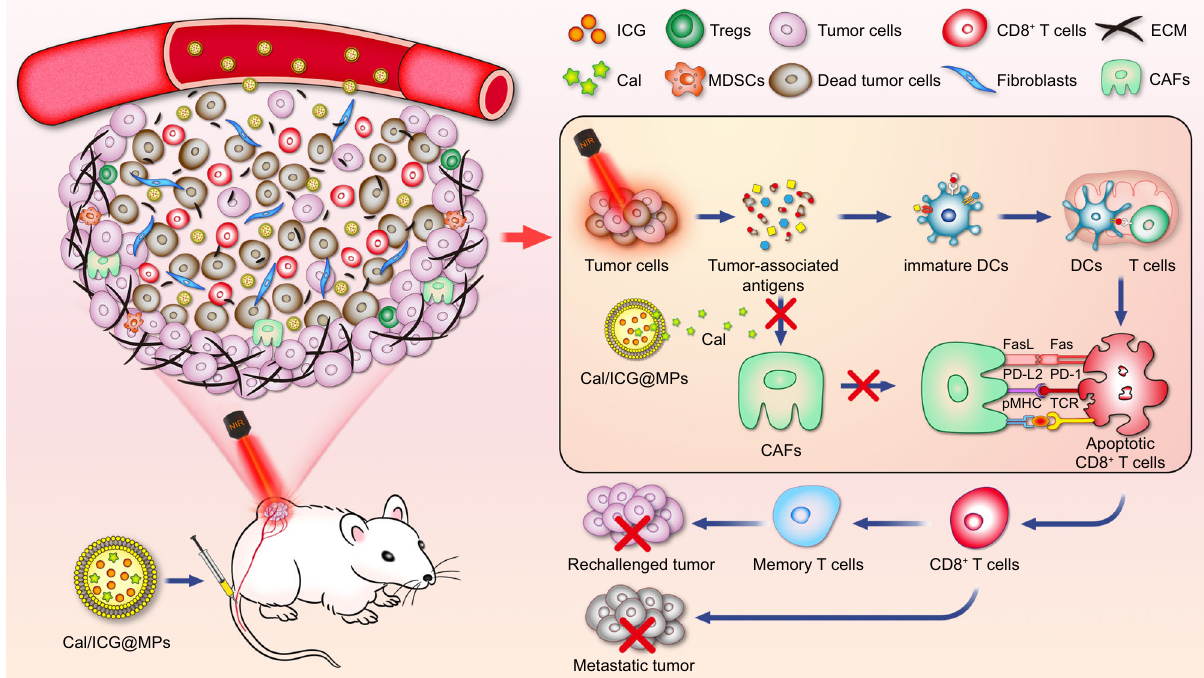
Fig. 1 Scheme of Cal/ICG@MPs as an ef fi cient drug to regulate CAFs to enhance PTT ef fi cacy. Cal/ICG@MPs ef fi ciently target tumor tissues and regulate CAFs. (1) Cal/ICG@MPs-induced CAF regulation reduces tumor ECM to enhance the tumor accumulation and penetration of ICG, leading to the enhanced PTT effects and inducing ICD of tumor cells to activate CD8 + T-cell-mediated antitumor immunity. (2) Cal/ICG@MPs-induced CAF regulation ef fi ciently recruits CD8 + T cells, promotes tumor in fi ltration of CD8 + T cells, and attenuates CAF-induced antigen-mediated AICD of tumor-speci fi c CD8 + T cells in response to PTT. (3) Cal/ICG@MPs generate strong antitumor immunity and elicit long-term immune memory upon 808 nm laser irradiation, inhibiting tumor recurrence and metastasis after